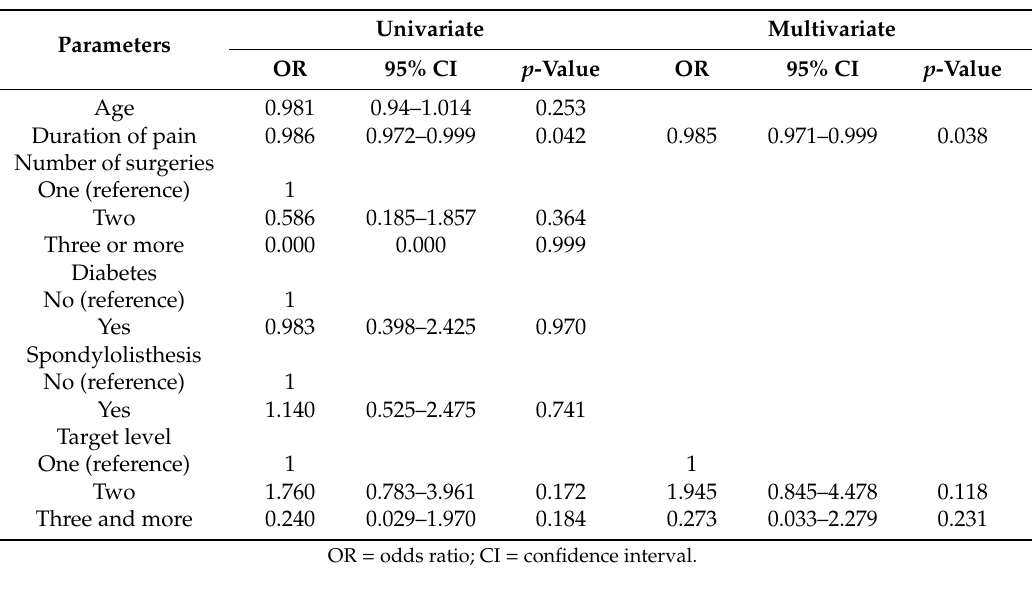
Table 5. Logistic regression analysis of factors associated with treatment response at six months after combined epidural adhesiolysis and balloon decompression in patients with lumbar post-laminectomy syndrome.